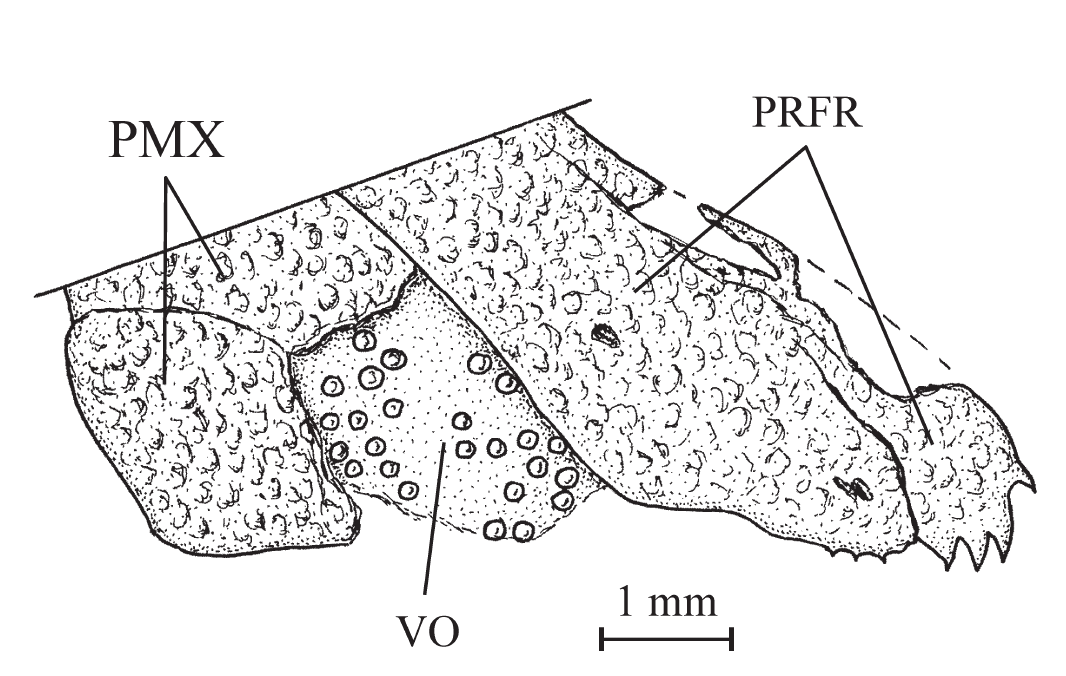
Fig. 10. Monocerichthys scheuchzeri gen. et sp. nov. The vomerian region of the skull in holotype CLC S-413b.